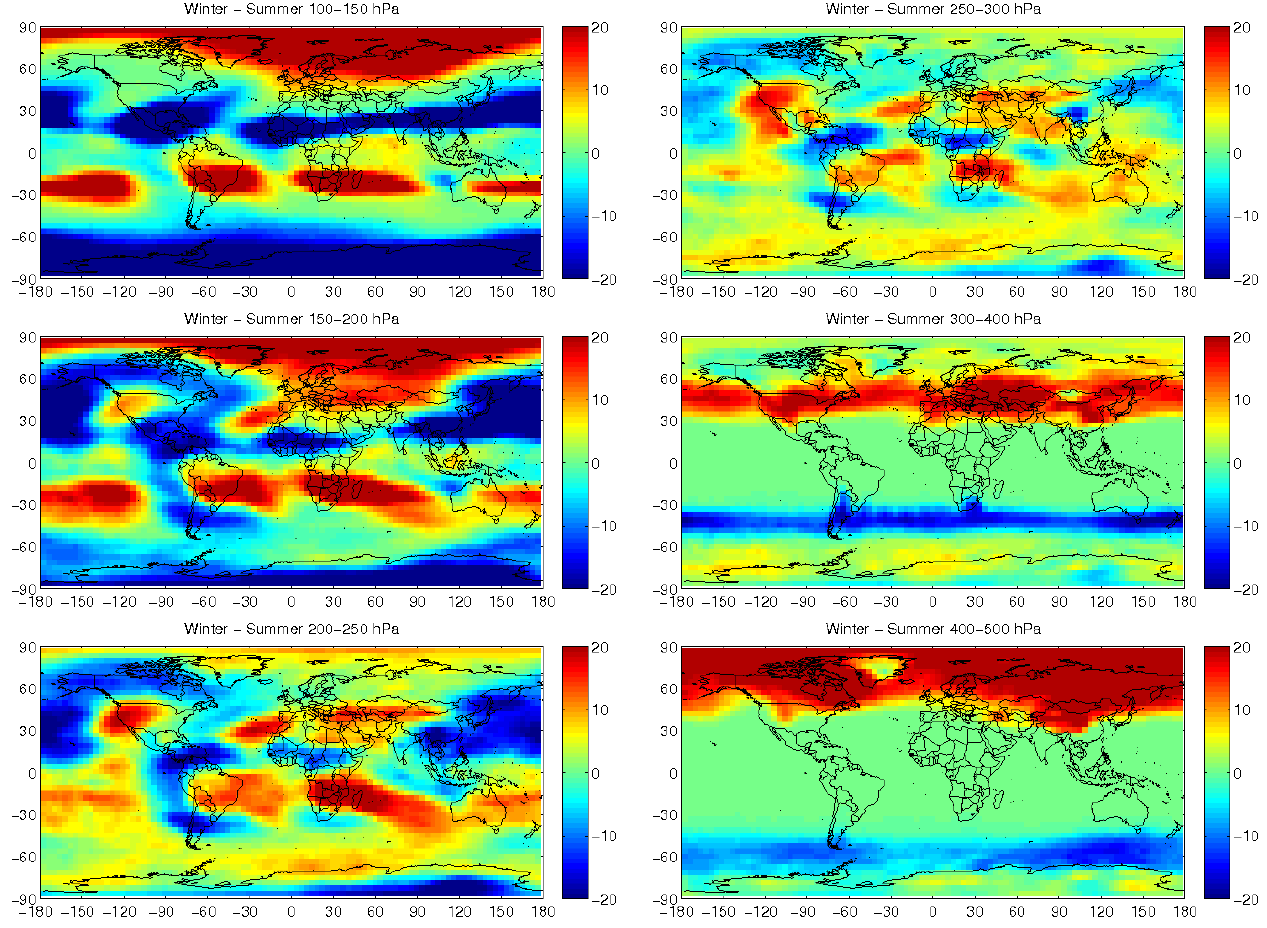
Fig. 20. Ice supersaturation occurrence frequencies (%) from ECHAM in the pressure layers 100–150, 150–200, 200–250, 250–300, 300–400 and 400–500hPa. Boreal winter – boreal summer. 5yr of